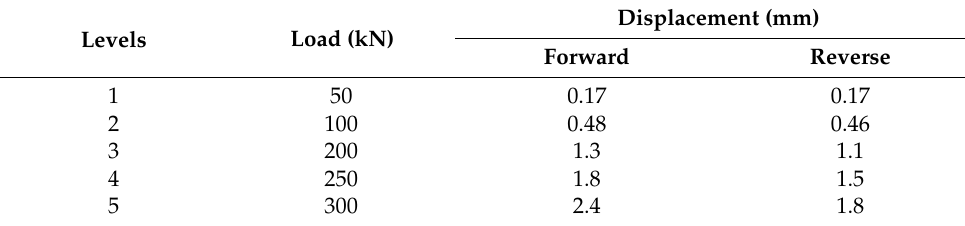
Table 4. Measured displacements under the first five loading levels.